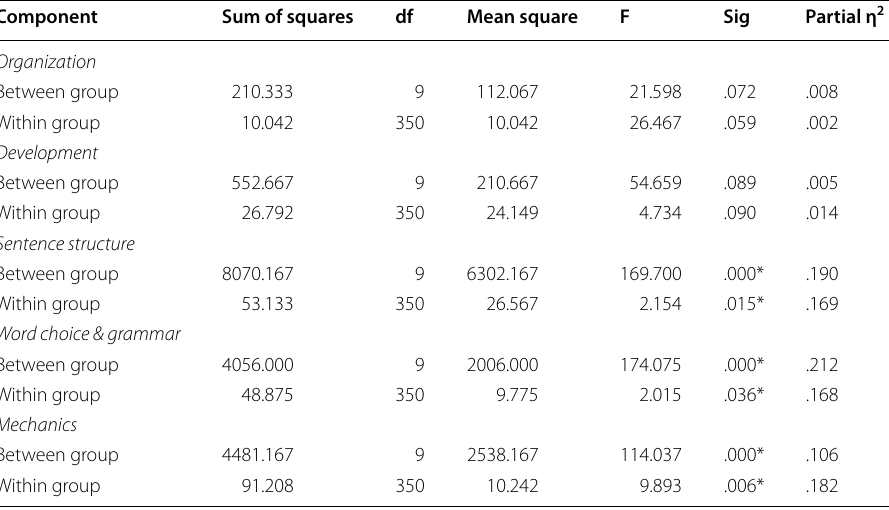
*Significant at the .05 level (2‑tailed)